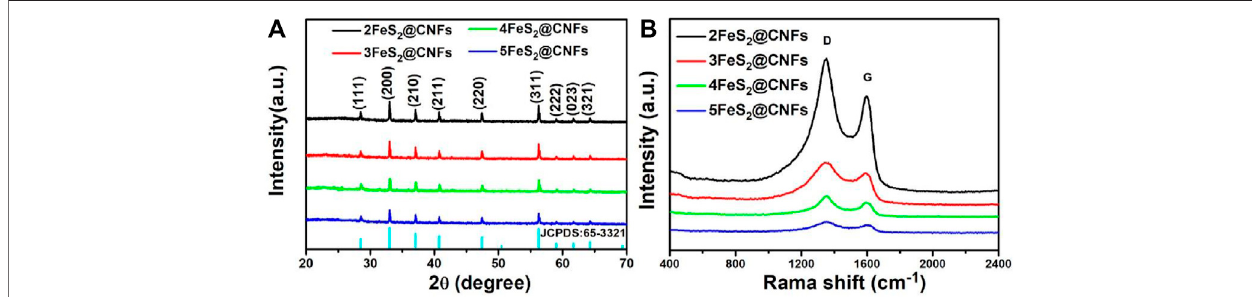
FIGURE 2 | (A) XRD patterns and (B) Raman spectra.